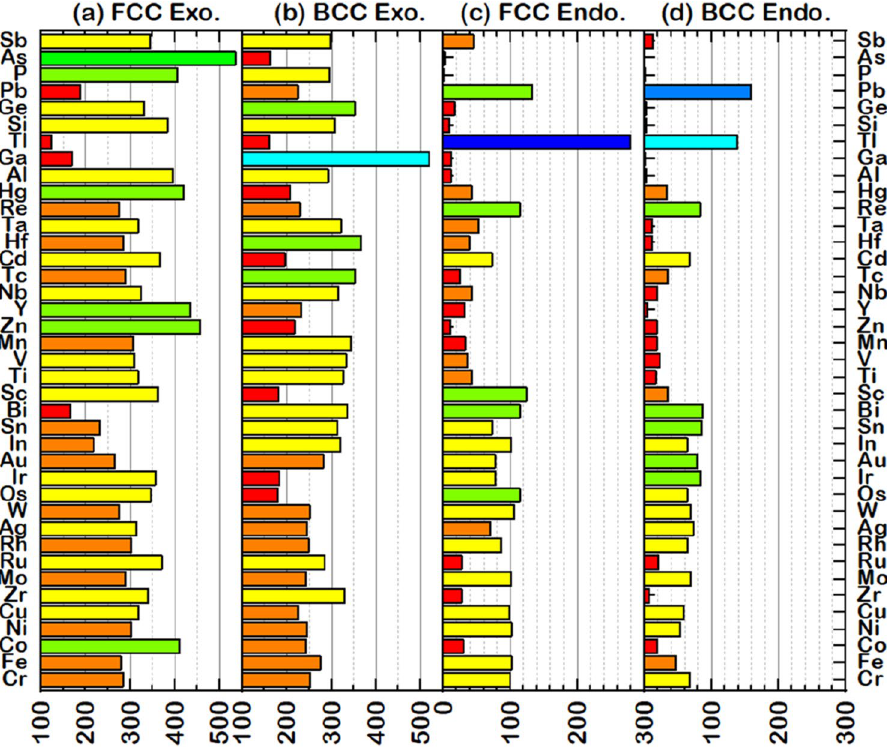
Figure 8. Distribution of elements counted from (cid:31) E f of PtPd XYZ HEAs ( X = Y = Z = Sc, Ti, V, Cr, Mn, Fe, Co, Ni, Cu, Zn, Y, Zr, Nb, Mo, Tc, Ru, Rh, Ag, Cd, Hf, Ta, W, Re, Os, Ir, Au, Hg, Al, Si, P, Ga, Ge, As, In, Sn, Sb, Tl, Pb, Bi) through ML-predicted results: ( a ) FCC exothermic cases, ( b ) BCC exothermic cases, ( c ) FCC endothermic cases, and ( d ) BCC endothermic cases. The color classification in each group is based on the frequency of the system found to have either FCC Exo, BCC Exo, FCC Endo, or BCC Endo.